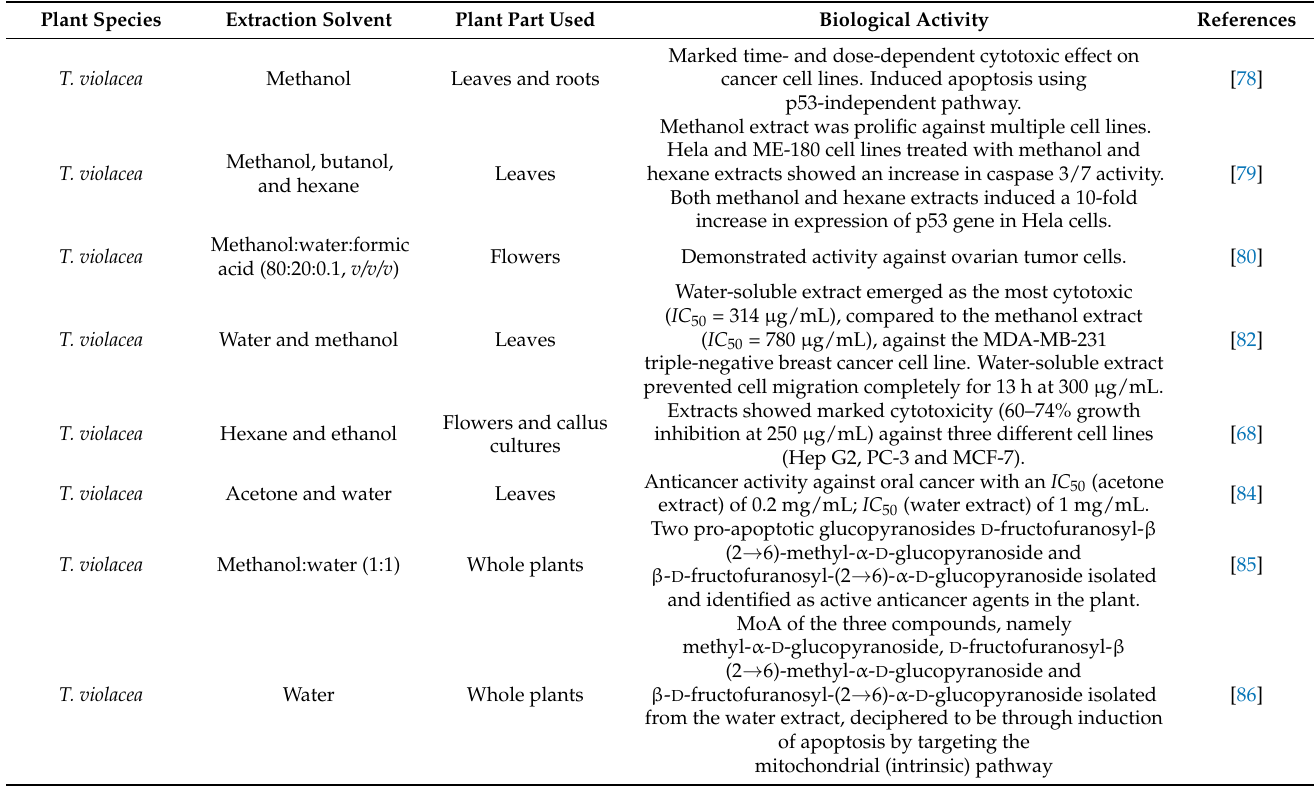
Table 5. Anticancer activity of Tulbaghia